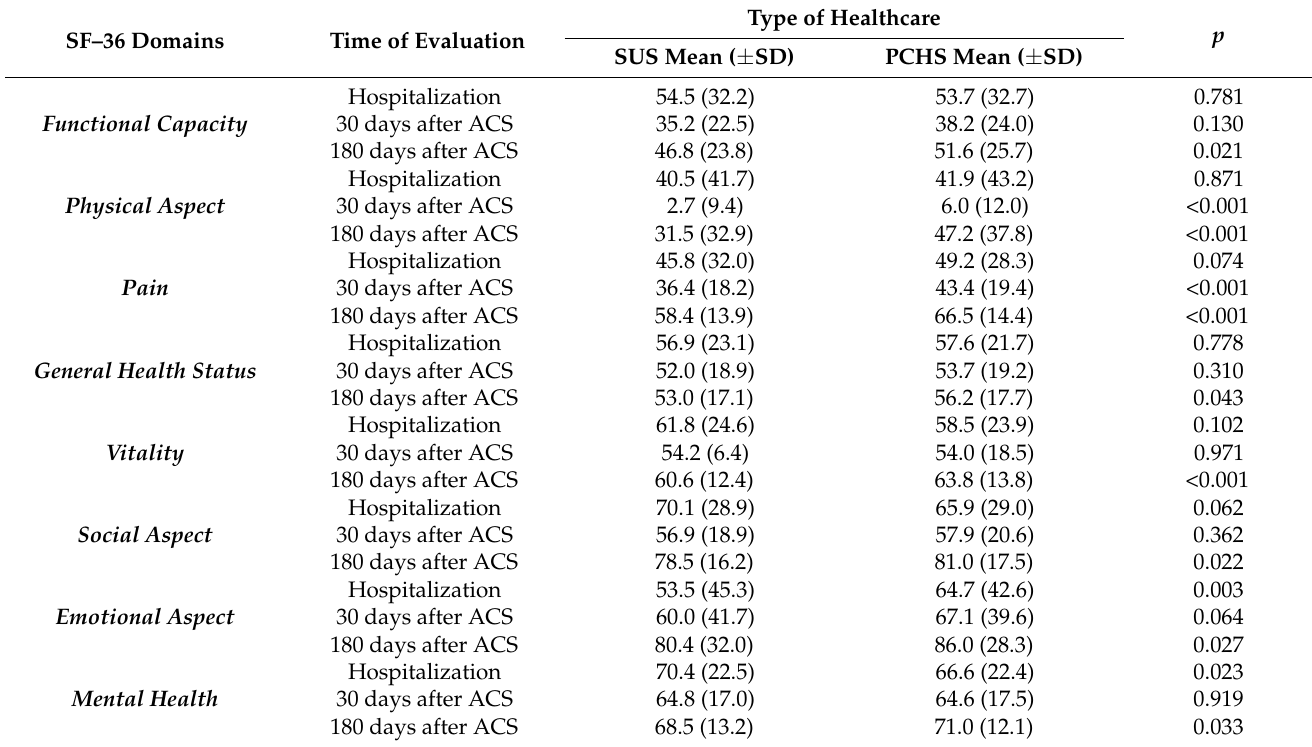
Table 3. Means and standard deviation of SF-36 domains of patients with ACS, according to the type of healthcare, Aracaju,